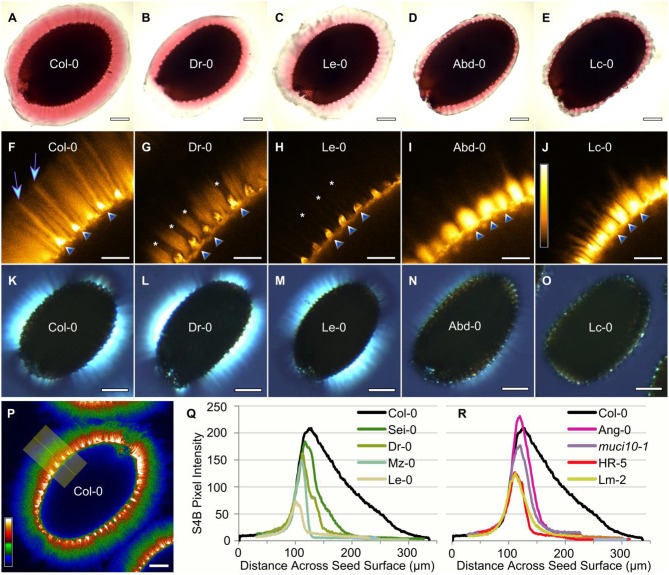
Altered distribution of pectin, cellulose and crystalline structures. Representative images for five of the accessions analyzed in Figure 1. RR-staining of adherent mucilage (A–E), S4B labeling of cellulose (F–J), and the birefringence of crystalline structures (K–O). S4B signals were visualized with Orange Hot (H–L), or Thal (Q) look-up tables in Fiji. Cellulosic rays are present in Col-0 (arrows) above columellae (triangles), but are absent in certain lines (asterisks). Based on S4B intensity across the seed surface (P), increased (Q), or decreased (R) mucilage Man content reduced cellulose distribution relative to Col-0. Plots were manually aligned, and the highest peaks represent the regions marked by triangles in (F–J). Scale bars = 200 μm (A–E,P); 50 μm (F–J); 250 μm (K–L).